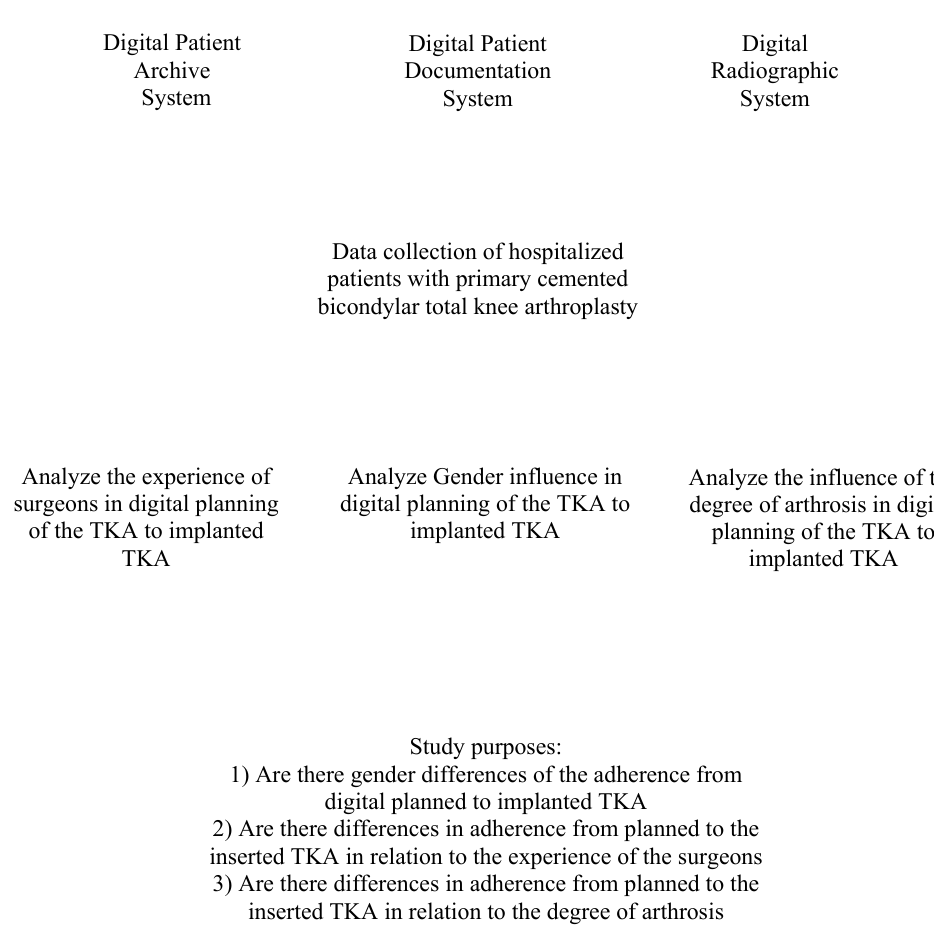
Figure 1. Workflow. Data acquisition was consecutive. First, the examination of cases was completed through the current patient recording system and, for control and additional data acquisition, through the archiving program of not digitally recorded documents. The examination of preoperatively planned implants was carried out through the digital X-ray image viewer. The data collection then was analyzed for the study purposes shown in the figure.